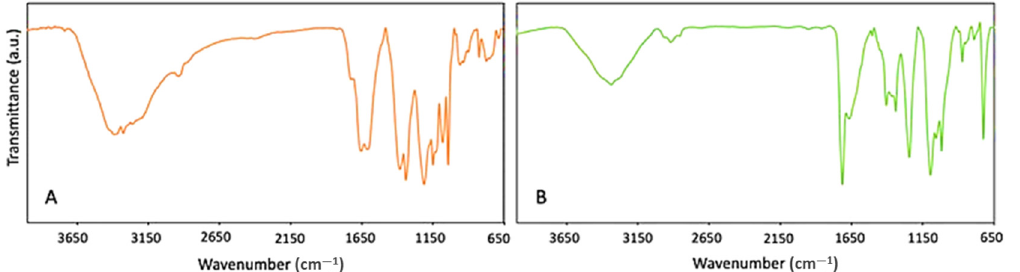
Figure 8. Example of micro-FTIR spectra of polymers found in wedge clams. Polyvinylidene chloride ( A ) and polyethylene terephthalate ( B ).